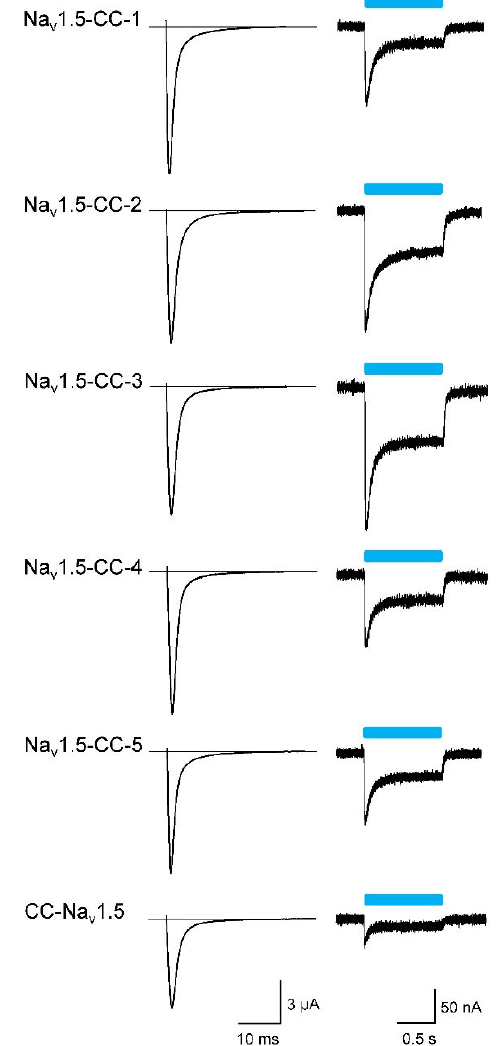
Figure 2. Representative Na + currents and light-activated photocurrents of the six fusion channels. Whole-cell currents were recorded three days after injecting about 5 ng cRNA per Xenopus oocyte at a test potential of − 20 mV (left; holding potential − 100 mV) and using a 1-s blue-light pulse (right; holding potential − 80 mV). For current data, number of measurements, and statistics, see Table 1. Table 2. Electrophysiological properties of three selected Na v 1.5-ChR2 channels compared to wild- type Na v 1.5 in Xenopus oocytes. The amount of cRNA per oocyte was as follows: 0.2 ng for Na v 1.5,